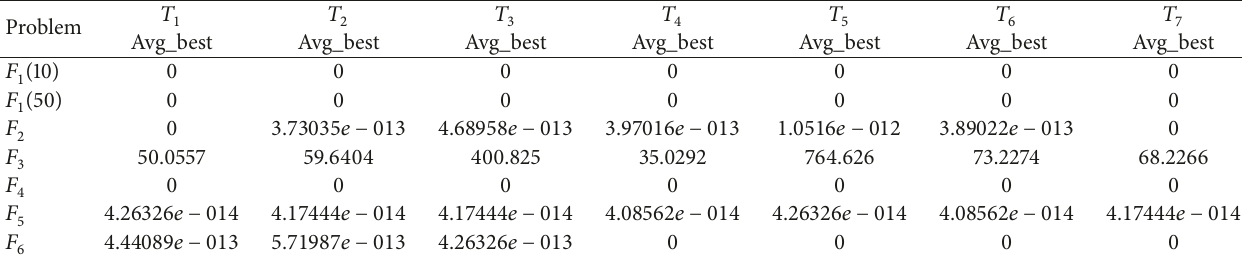
Table 6: Average best error values achieved for problems 𝐹 1 – 𝐹 6 by Shrinking-based BA.